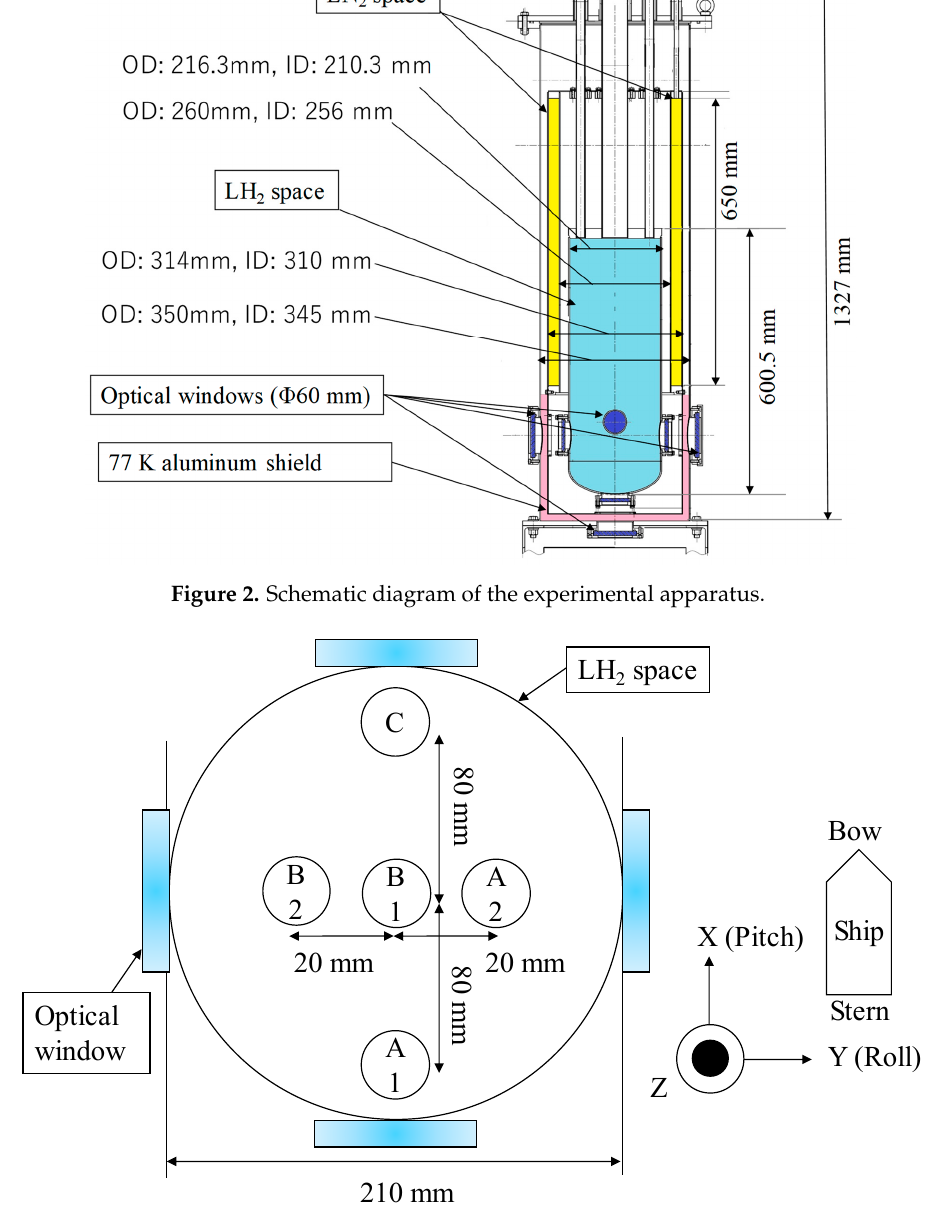
Figure 3. Layout of the five MgB 2 level sensors with a diameter of 0.32 mm.